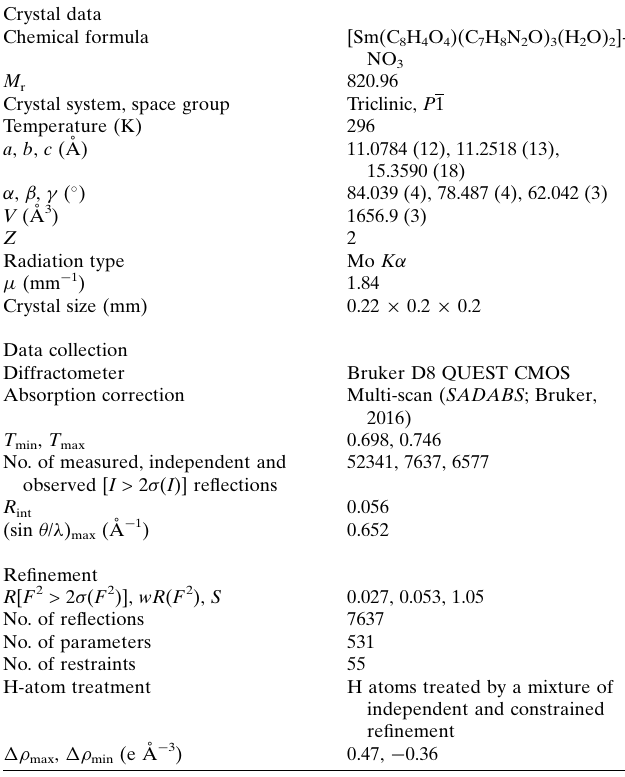
Table 2 Experimental details. Crystal data Chemical